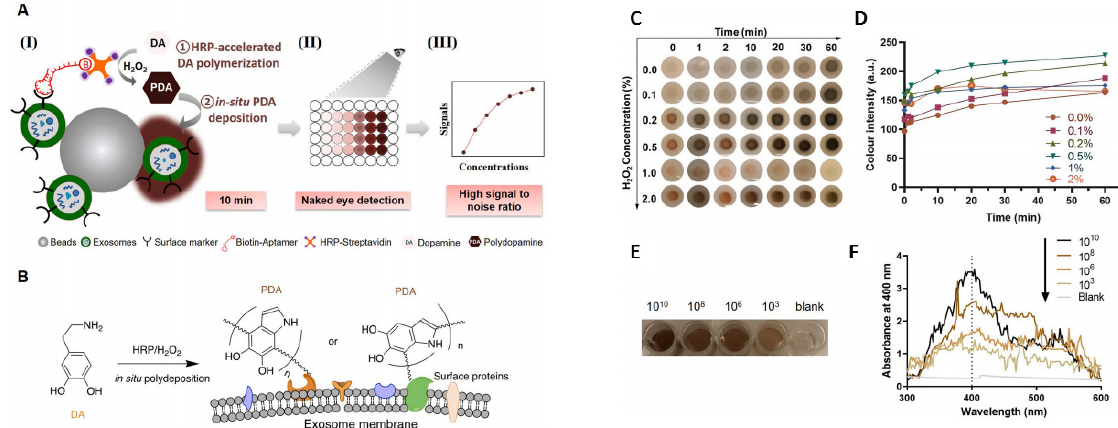
Figure 4. ( A ) ( I ) Exosomes were anchored on sulfate/latex beads by aldimine condensation followed by binding to a CD63-specific aptamer conjugated to biotin. Incubation with streptavidin-conjugated HRP converted colorless dopamine (DA) into brown-black colored polydopamine (PDA). ( II ) The color change is proportional to exosome concentrations. ( III ) The absorbance signals of the reaction can also be measured at 400 nm. ( B ) Schematics of the deposition of PDA onto the exosome membrane. ( C ) The color change of PDA deposition at the target site of HRP at different H 2 O 2 concentrations. ( D ) The change in the color intensity is a function of time and H 2 O 2 concentration. ( E ) Images of exosome samples after color development in the ExoAptaSensor. ( F ) Absorbance peak at 400 nm correlates with exosome concentrations. Reprinted from Development of a simple, sensitive, and selective colorimetric aptasensor for the detection of cancer-derived exosomes, Volume 169, Xu et al., 2020a, Page No. 112576, Copyright 2020, with permission from Elsevier.